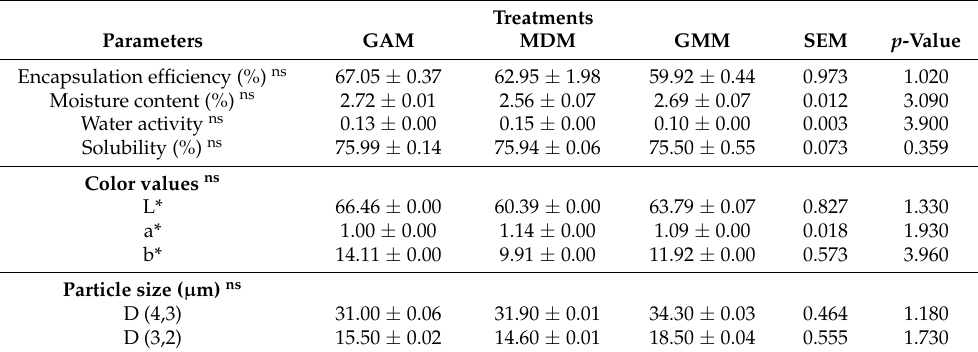
Table 5. Effects of encapsulation by spray-drying on quality properties of microcapsules.